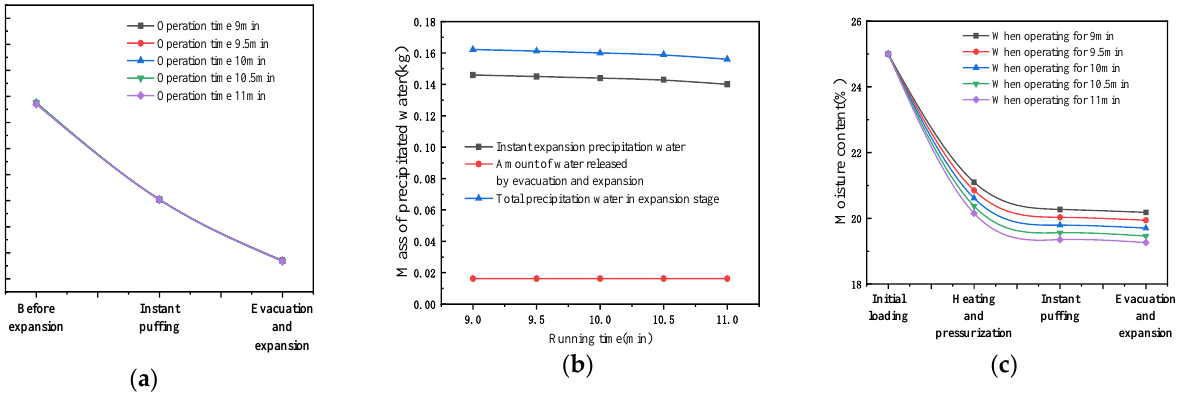
Figure 6. Effect of tank pressure on mass transfer in expansion stage. ( a ) Effect of pressure in the pressure section on drying temperature of expanded fruit. ( b ) Influence of the pressure in the pressure section on the water release in the expansion section. ( c ) Effect of pressure in the pressure section on dry fruit moisture content.